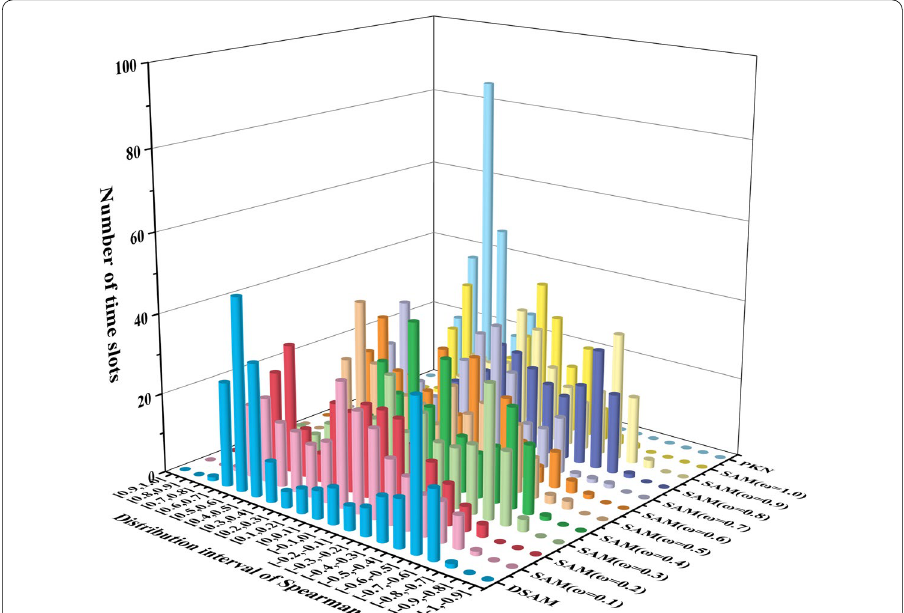
Fig. 6 Distribution of Spearman values calculated for the 235 time slots of